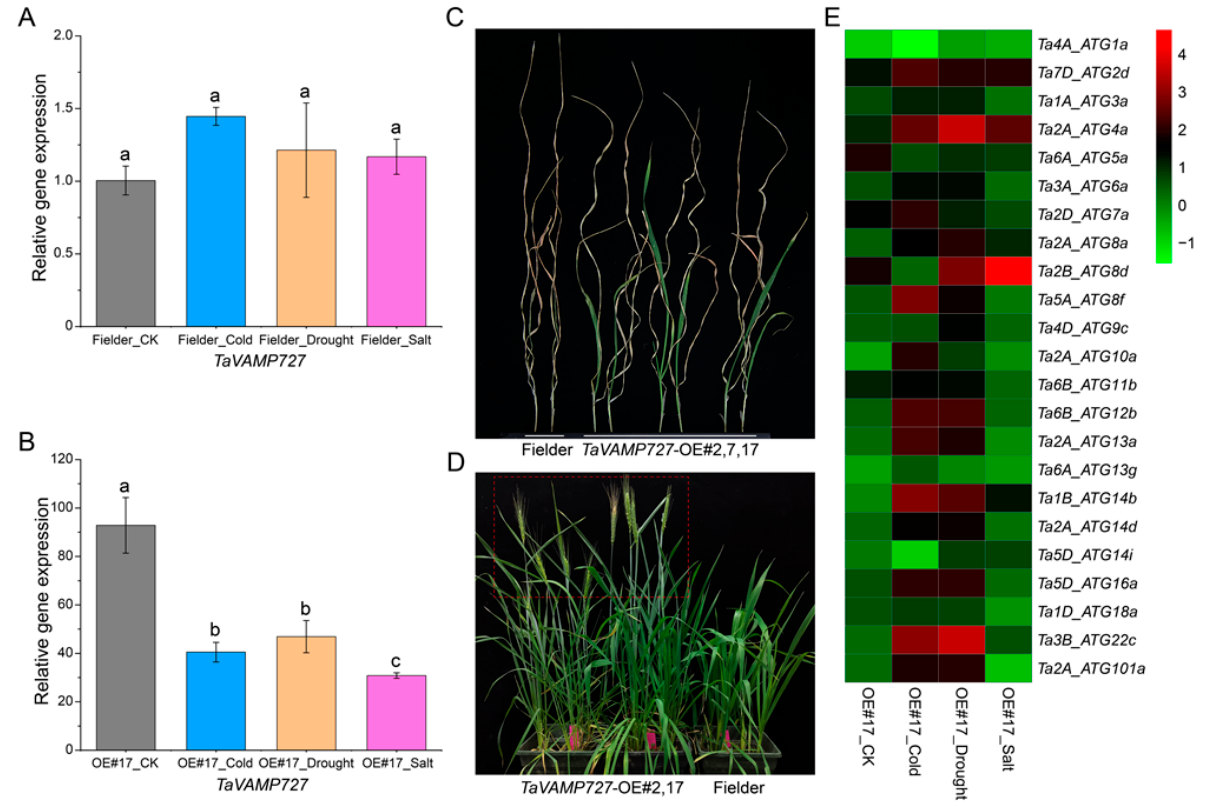
Figure 8. Overexpression of TaVAMP727 in wheat. ( A , B ) The expression level of TaVAMP727 in overexpressed line and Fielder (WT) under cold (4 °C) for 12 h, air-dry for 6 h and salt (150 mM NaCl solution) for 24 h. Error bars represent the SD. Columns bars followed by different letters are statistically different according to the analysis of variance followed by Duncan’s Multiple Range Test (A, p = 0.1947; B, p = 0.0005; n = 3). ( C ) Survival rate determination of trileaf stage Fielder and TaVAMP727 transgenic wheat seedlings under drought stress. ( D ) The heating date comparison of Fielder and TaVAMP727 transgenic lines. ( E ) The relative expression levels of 23 TaATGs in TaVAMP727 overexpressed line under diverse abiotic stresses. The glyceraldehyde-3-phosphate dehydrogenase (GA3PD) was used as housekeeping